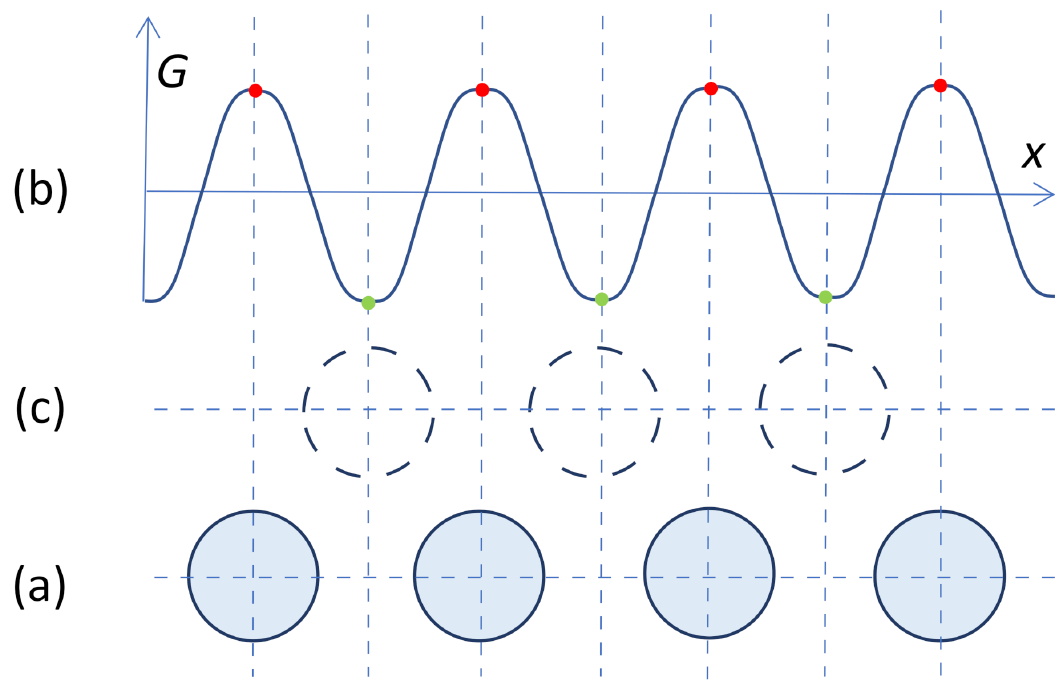
Figure 27. A 2D illustration of structural templating as a mechanism for transforming liquid atoms into solid atoms at the crystalline/liquid interface. ( a ) Front view of the equilibrium atomic positions in a crystalline plane; ( b ) schematic illustration of the potential energy (G) of an atom in the next atomic layer as a function of its position ( x ). The potential energy has maxima (red dots) right above the solid atoms and minima (green dots) between the two solid atoms; and ( c ) schematic illustration of the potential equilibrium atomic positions in the next layer (the dashed